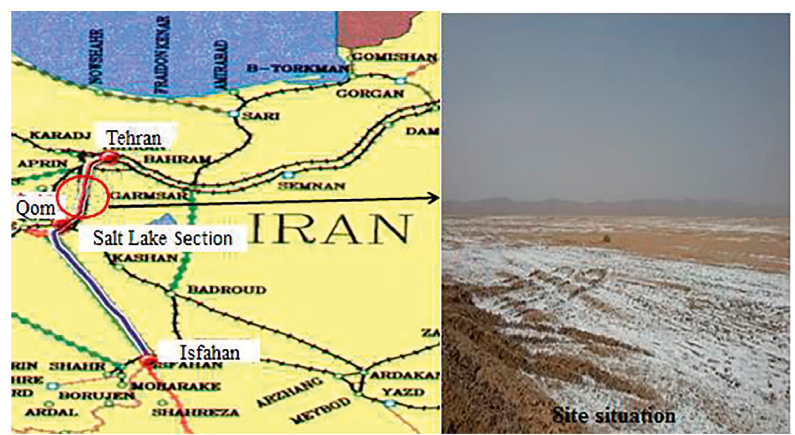
Figure 1: Geological location of the